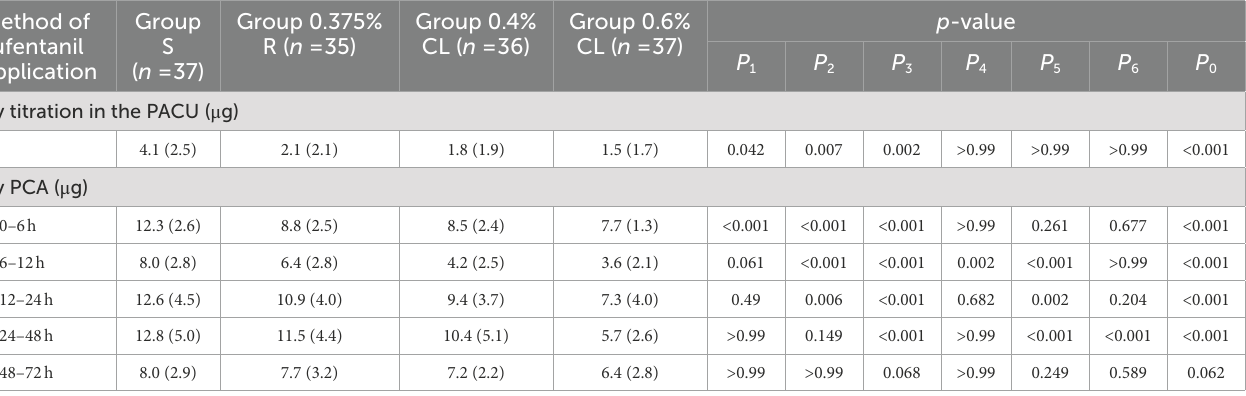
TABLE 2 Postoperative sufentanil consumption.